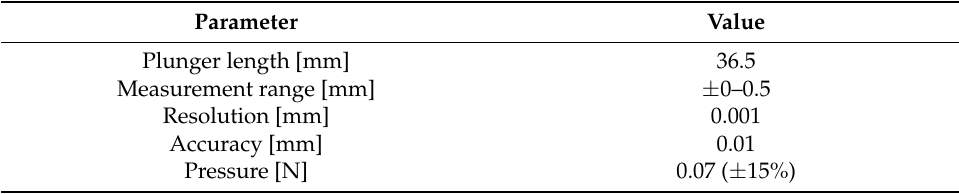
Table 5. Technical specification of the Sylvac CL44 sensor [54].